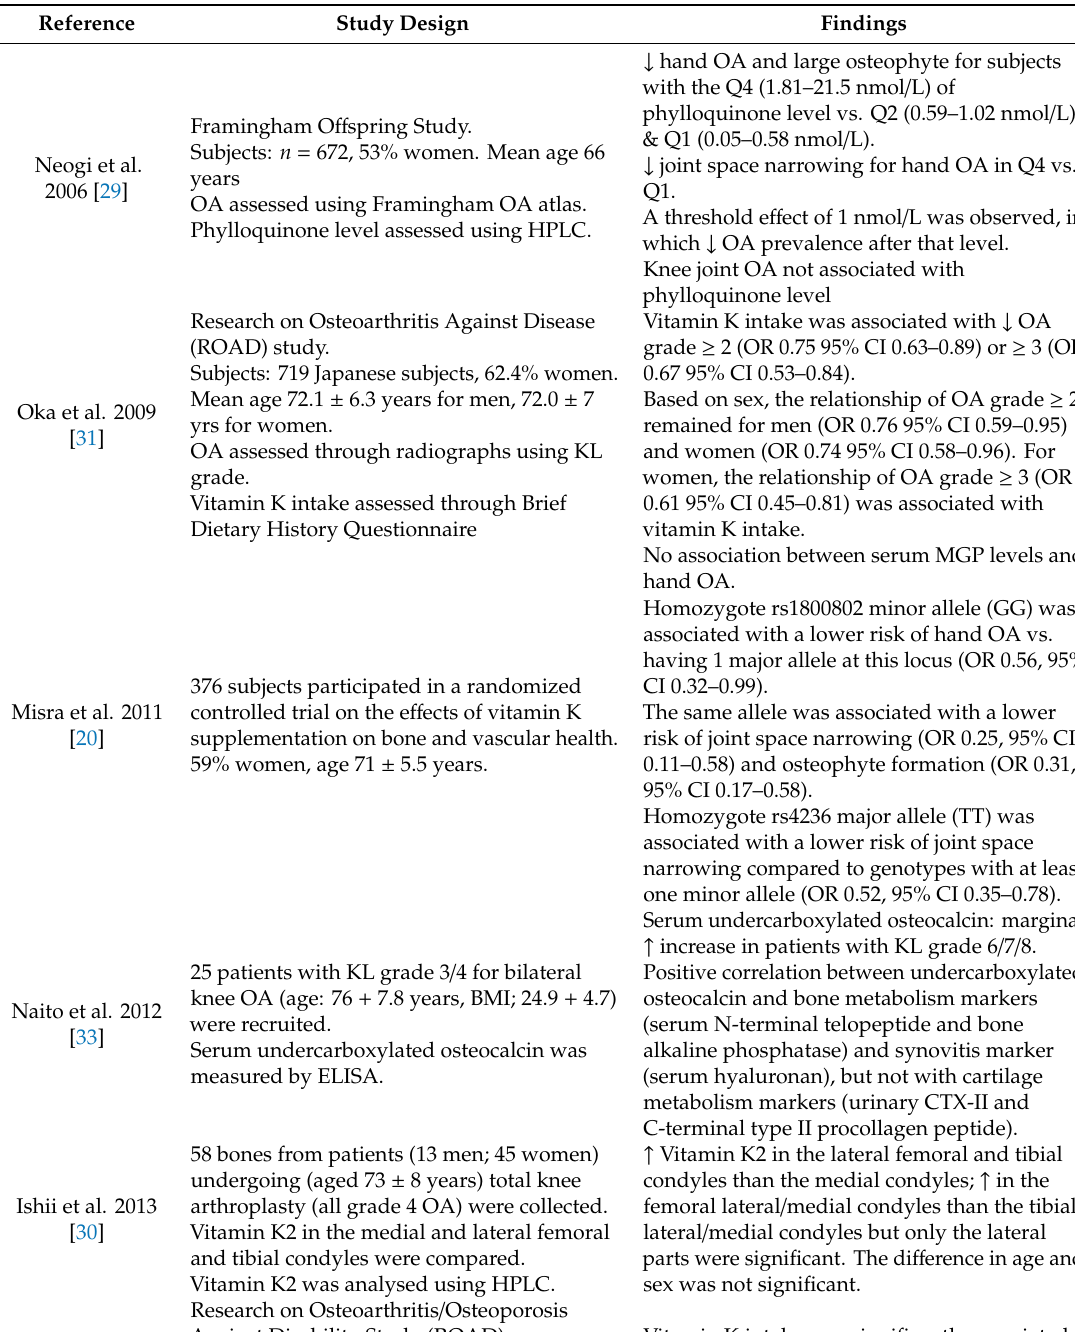
Table 2. The relationship between vitamin K status and osteoarthritis (OA) from cross-sectional